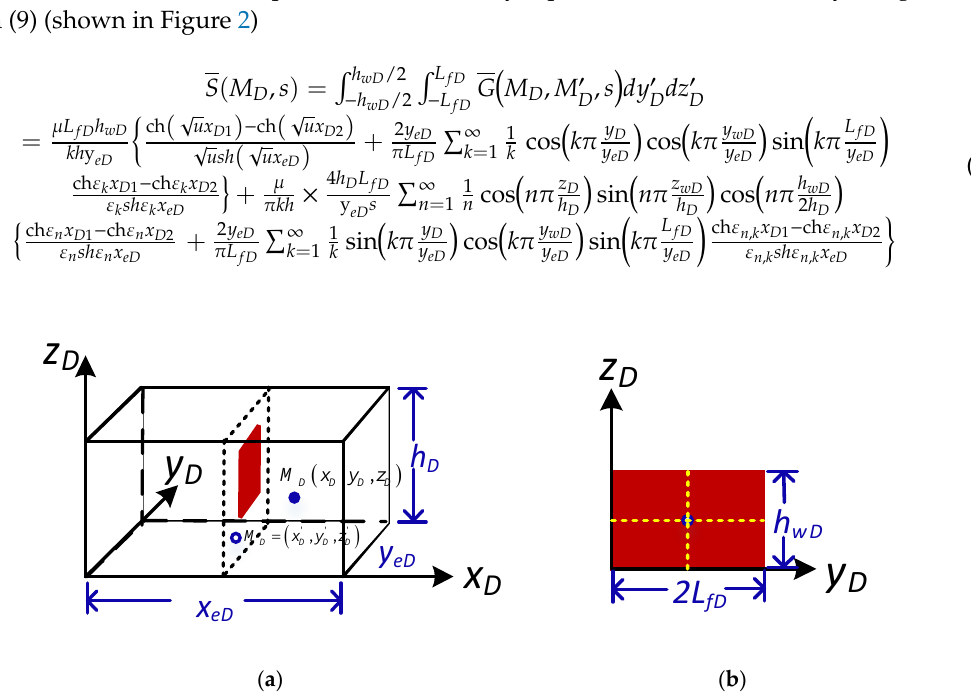
Figure 2. A plane perpendicular to the x -axis in the rectangular parallelepiped. ( a ) One block with hydraulic fracture; ( b ) the fracture plane.